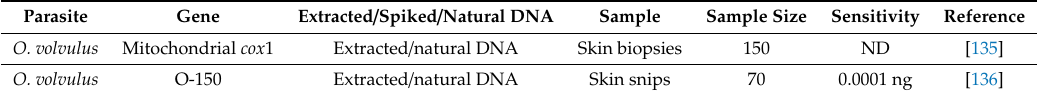
Table 12. Publications found in the US National Library of Medicine National Institutes of Health (NCBI-PubMed) reporting the standardisation of the LAMP technique as a useful tool for diagnosing onchocerciasis (river blindness) in the definitive host.